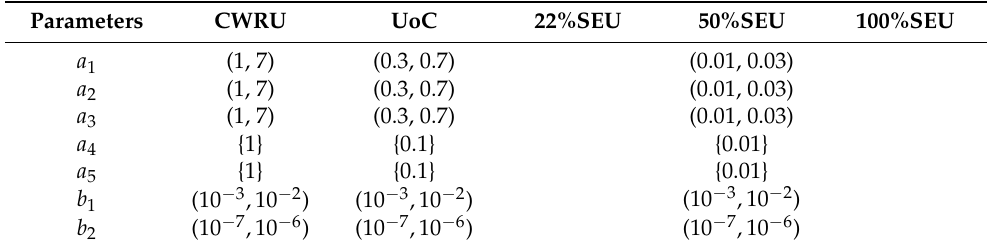
Table 9. Value ranges of the parameters a i and b j .